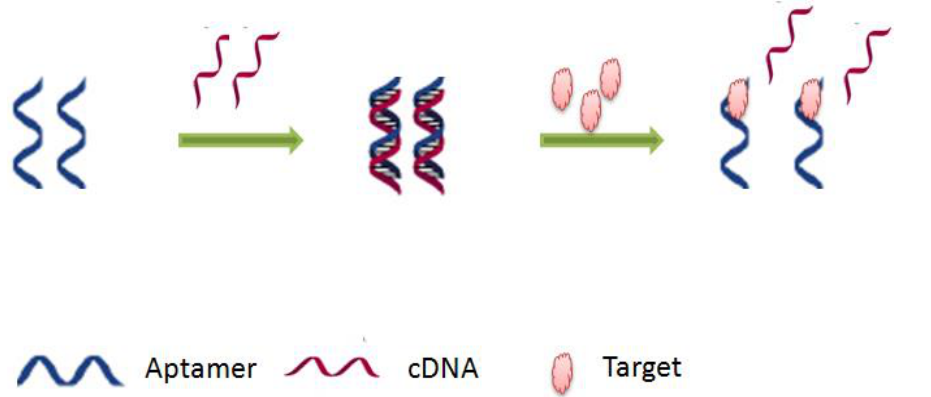
Figure 3. Principle of target-induced strand displacement aptasensing.